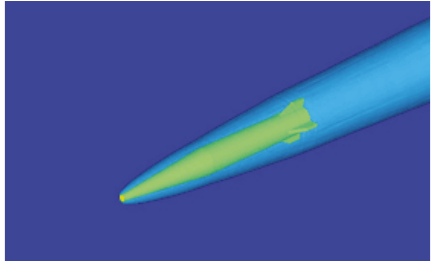
Figure 1: Illustration of vehicle inside supercavity.